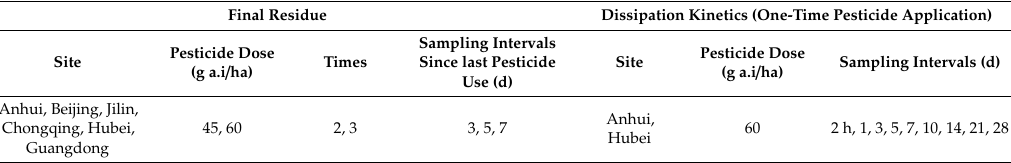
Table 3. Experimental design of field